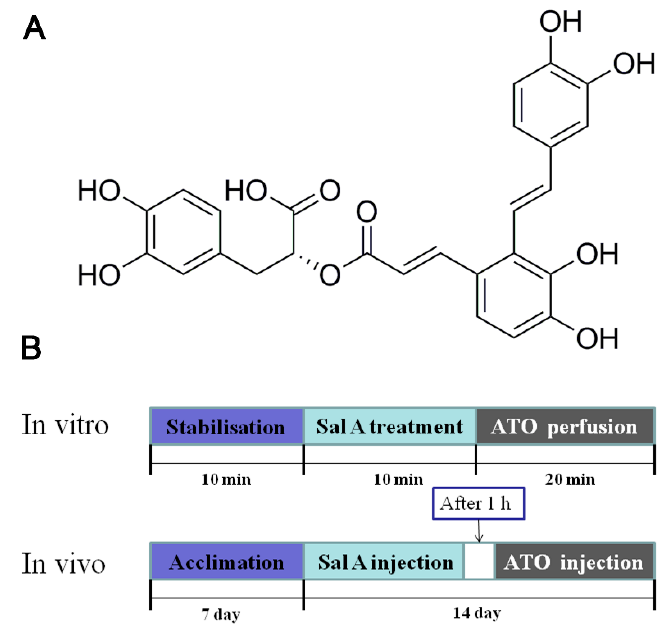
Figure 1. ( A ) Molecular structure of salvianolic acid A (Sal A). ( B ) The in vivo and in vitro experimental designs. ATO, arsenic trioxide.